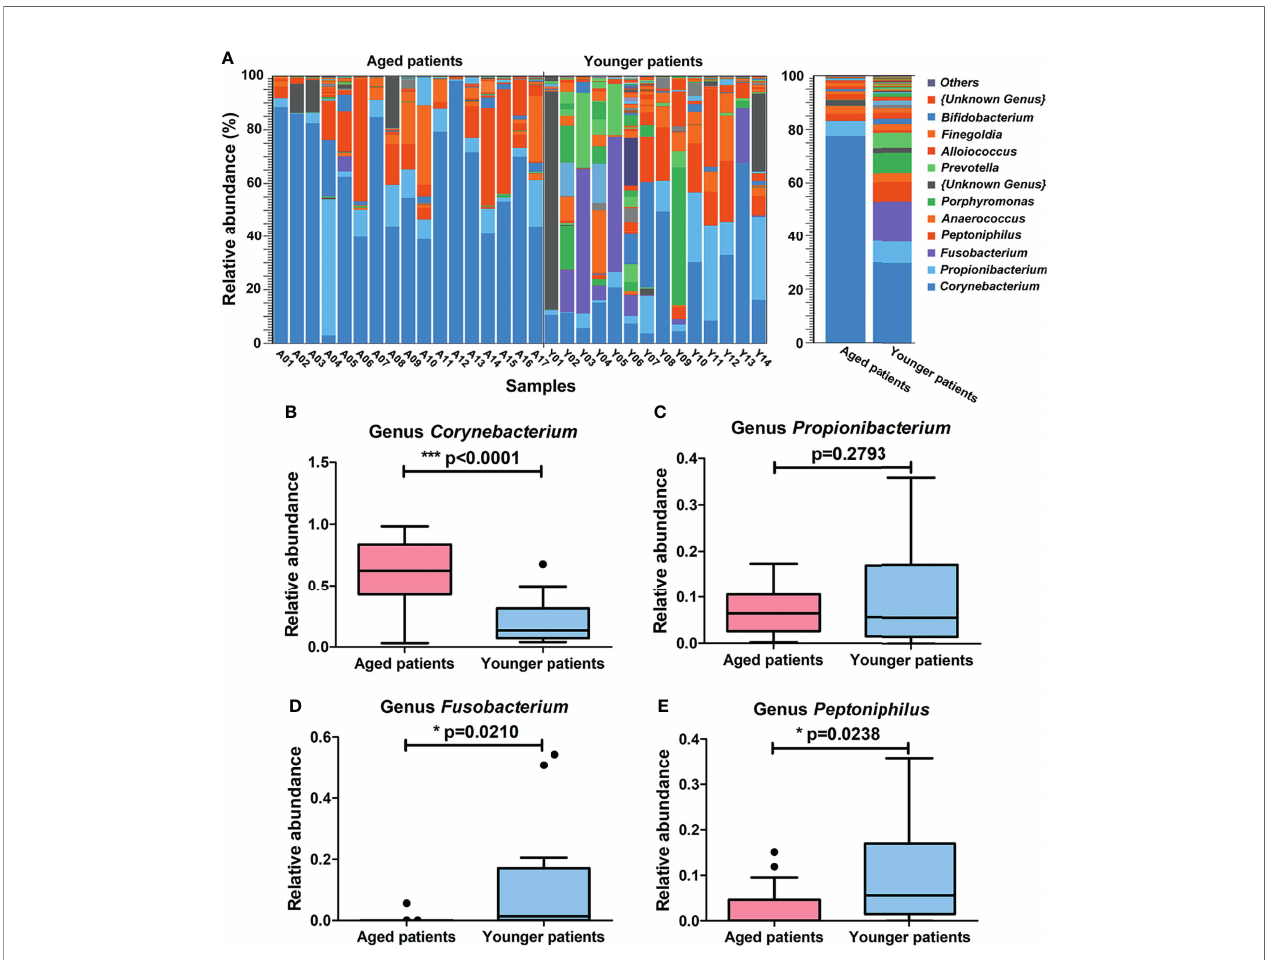
FIGURE 4 | Differences in composition of bacterial community at the genus level between aged and younger patients. (A) Relative abundance (%) of bacterial taxa at genus level of the nasal cavity of patients with CRS and comparison of bacterial abundance between aged and younger patients. (B – E) Mean Corynebacterium , Propionibacterium , Fusobacterium and Peptoniphilus abundance were compared between aged and younger patients. *p < 0.05, and ***p <